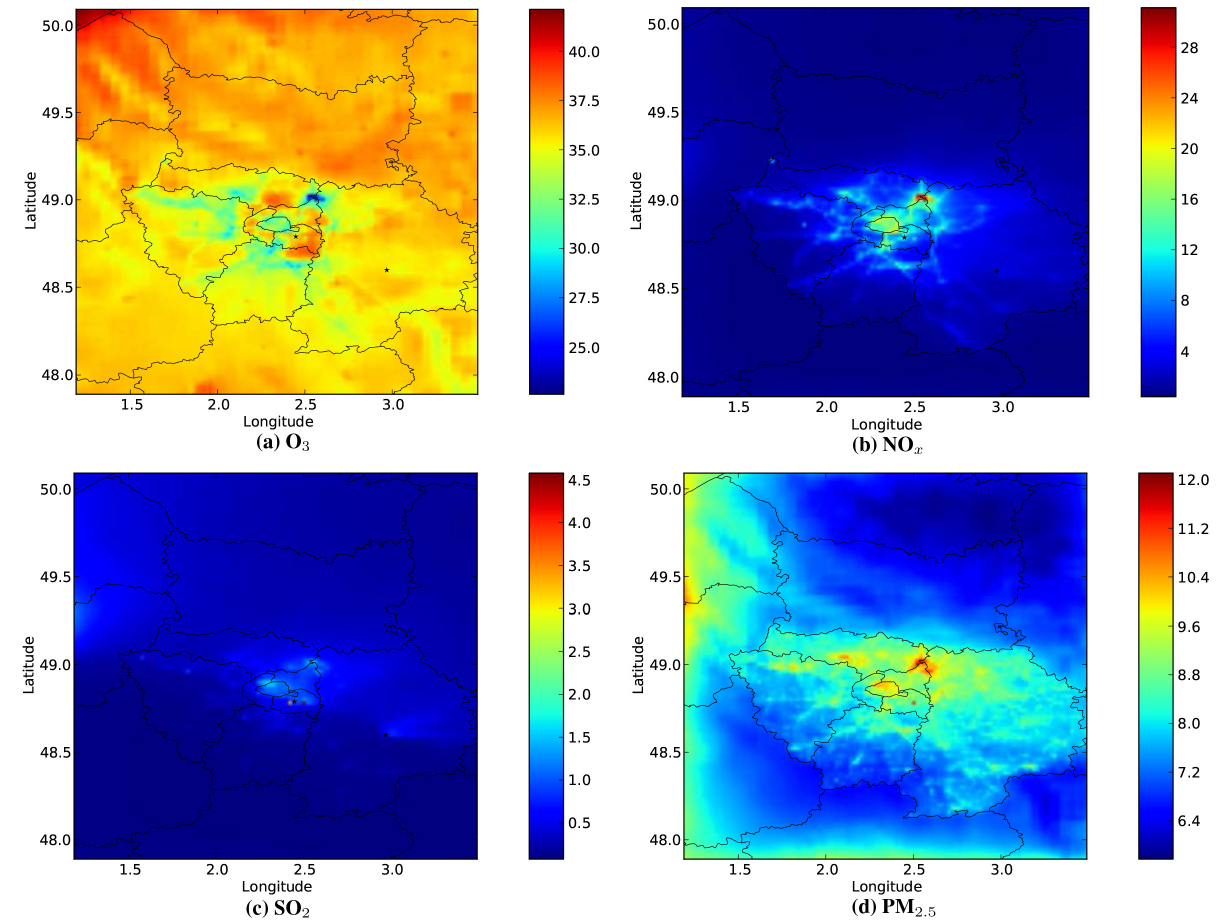
Fig. 3. Mean surface concentrations for 4–29 July 2009 over the Greater Paris domain obtained with the Reference simulation: (a) O 3 (ppb), (b) NO x (ppb), (c) SO 2 (ppb), (d) PM 2 . 5 (µgm − 3